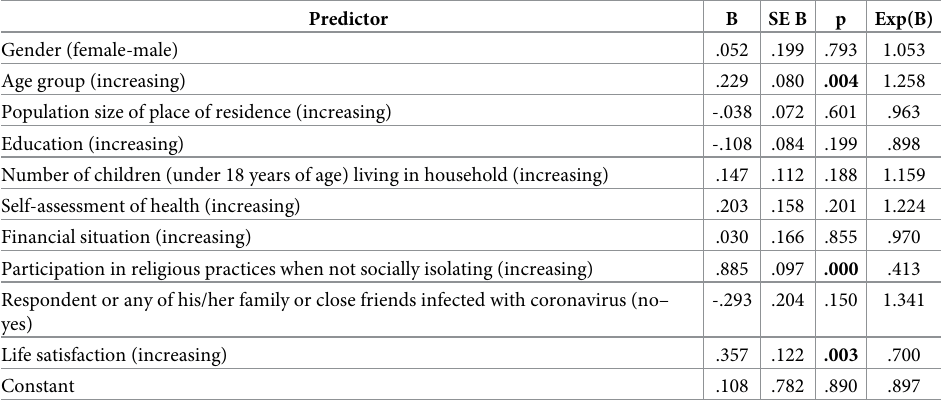
Table 4. The logistic regression analysis predicting increase in religious commitment based on respondents’ socio-demographic characteristics (N = 1761 �